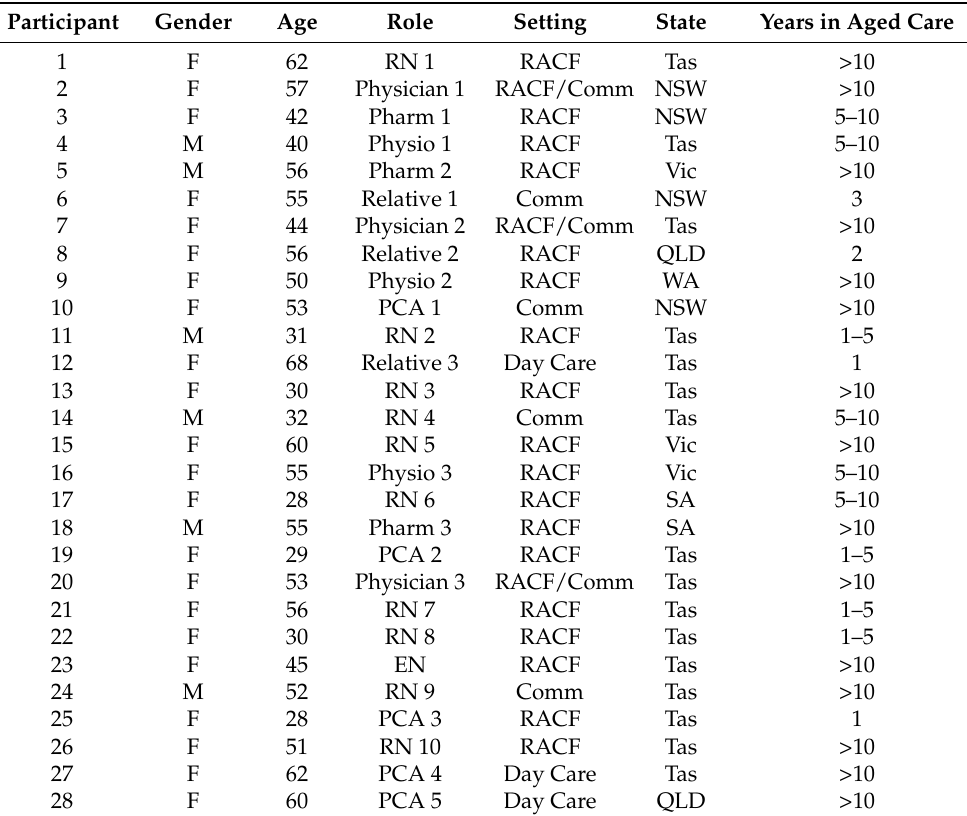
Table 2. Semi-structured interview participant demographic